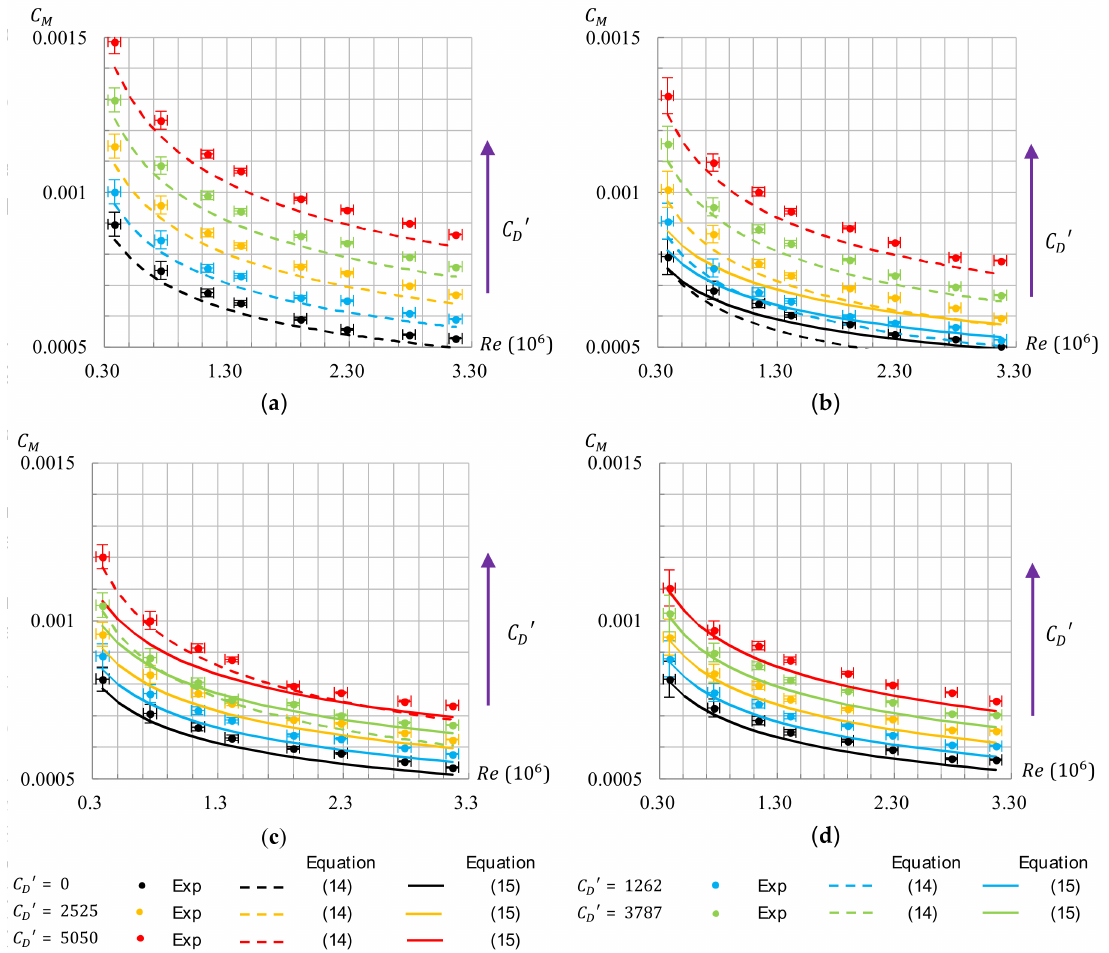
Figure 14. C M ( Re ) curves: ( a ) G = 0.018; ( b ) G = 0.036; ( c ) G = 0.054 and ( d ) G = 0.072. C D (cid:48) : through-flow coefficient; C M : moment coefficient; Re : global circumferential Reynolds number; G : non-dimensional axial